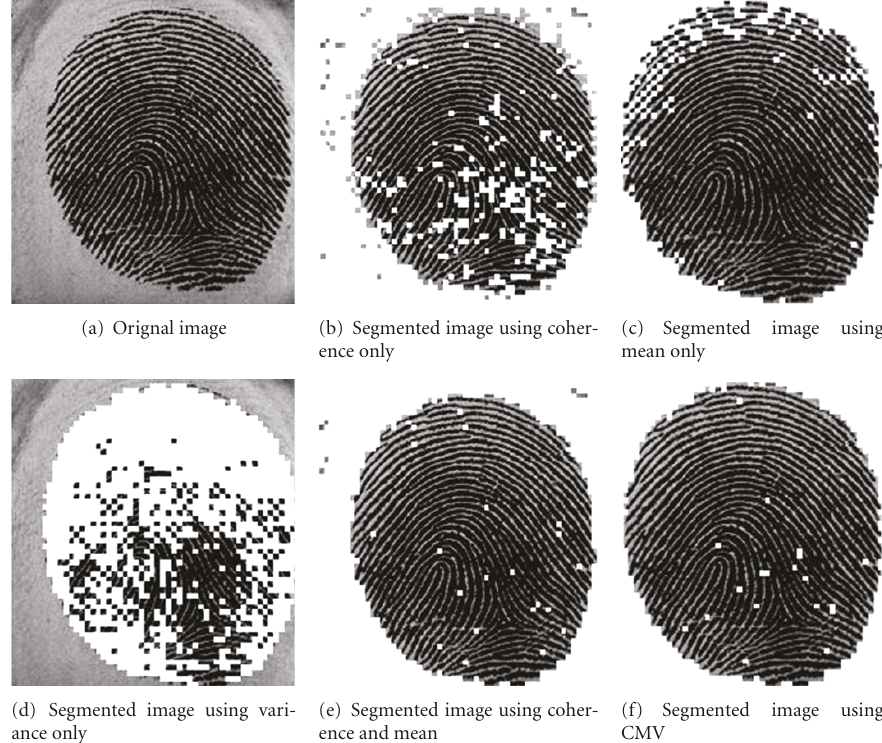
Figure 7: Segmentation results of SKI on fingerprint image FVC2000 DB3 82 1.tif using di ff erent feature combinations, that is, coherence only, mean only, variance only, the combination of coherence and mean, and the combination of coherence, mean, and variance.